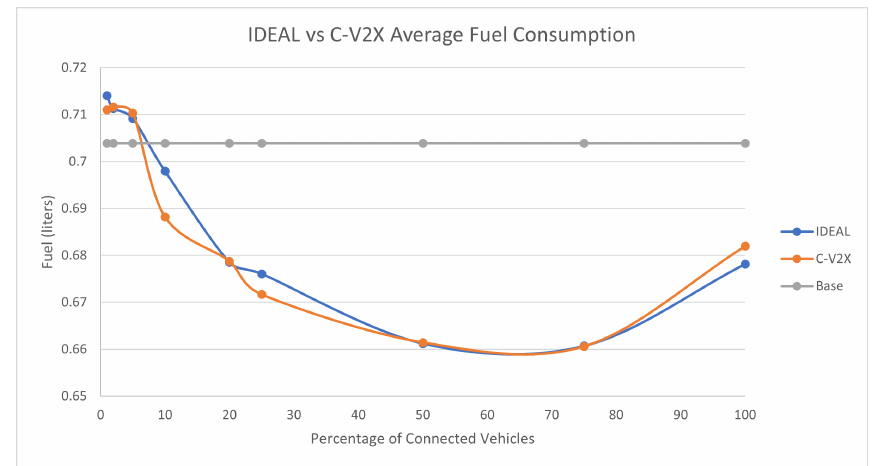
Figure 7. Average network-wide Fuel consumption of Energy-Efficient dynamic routing application using IDEAL and C-V2X communication on LA road network with traffic demand of scale factor 0.75.